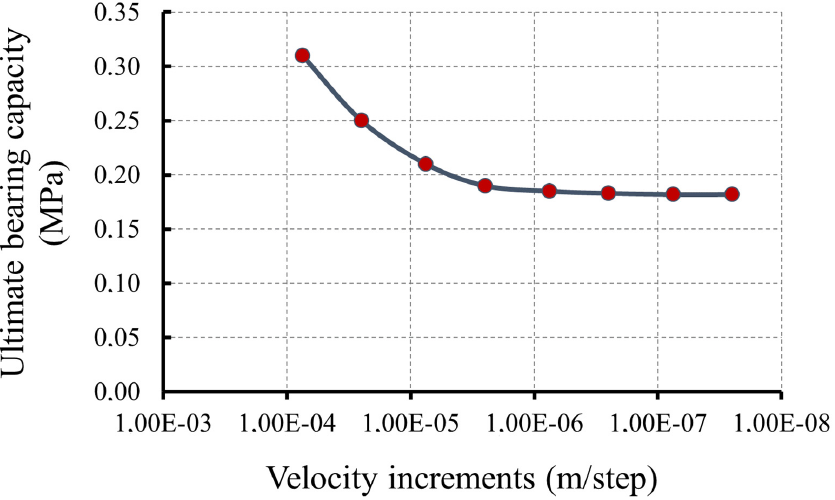
Figure 3. The bearing capacity vs. velocity increments diagram of the central node of the footing ( m i = 5, B = 4.5 m, UCS = 5 MPa, and GSI = 10).